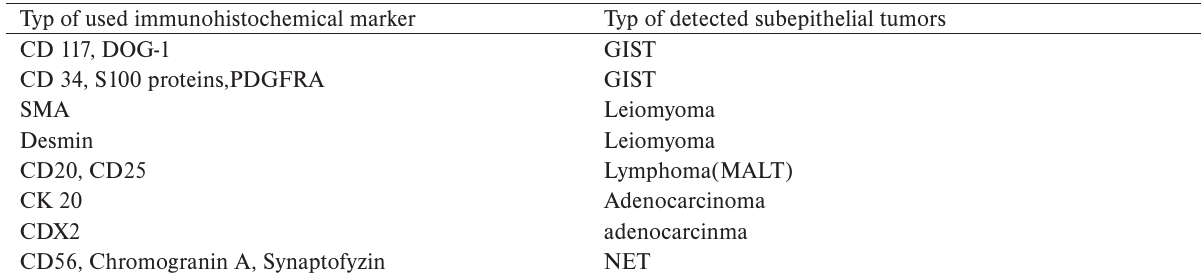
Table 1. Immunohistochemical markers used to confirm the diagnosis of subepithelial tumors.